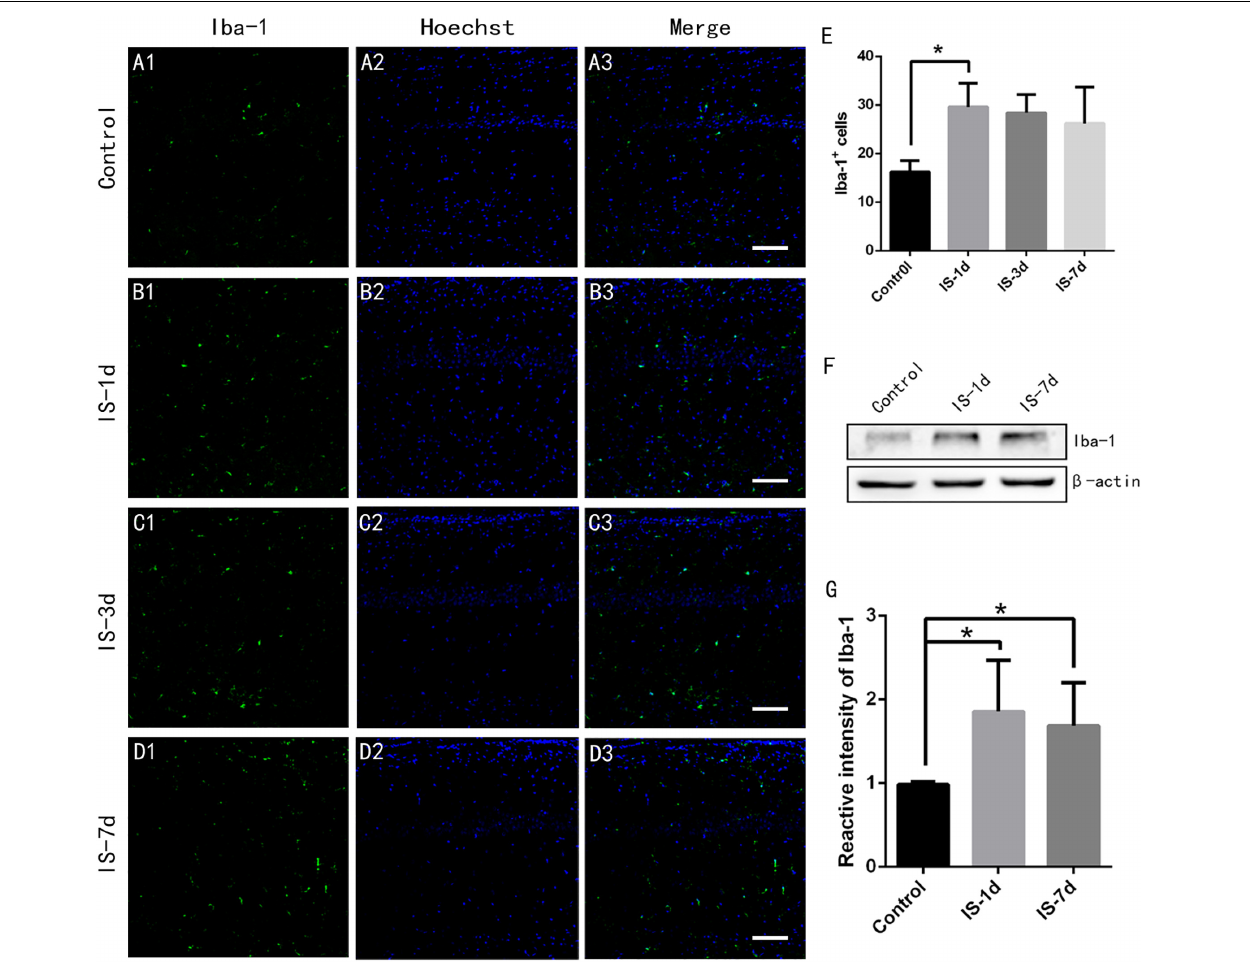
FIGURE 3 | Microglial cells in rat hippocampus increased after 1 day of infrasound exposure. (A1–A3) Microglial cells in the CA1 region of the rat hippocampus labeled with Iba-1 in the control group without infrasound exposure, (B1–B3) in the IS-1d group (1 day infrasound exposure), (C1–C3) IS-3d group (3 days infrasound exposure), and (D1–D3) in the IS-7d group (7 days infrasound exposure). (E) Quantitative analysis of Iba-1 + cells per 625 µ m × 625 µ m in the CA1 region of the rat hippocampus by immunofluorescence staining. (F) Iba-1 expression in rat hippocampus in the control group, IS-1d group, and IS-7d group by western blotting. (G) Semi-quantitative analysis of Iba-1 expression in rat hippocampus in the control group, IS-1d group, and IS-7d group by western blotting. Nuclei stained with Hoechst. Scale bar: 100 µ m. N = 6–8 for each experiment. One-way ANOVA. Values are all expressed as mean ± SD. ∗ P <